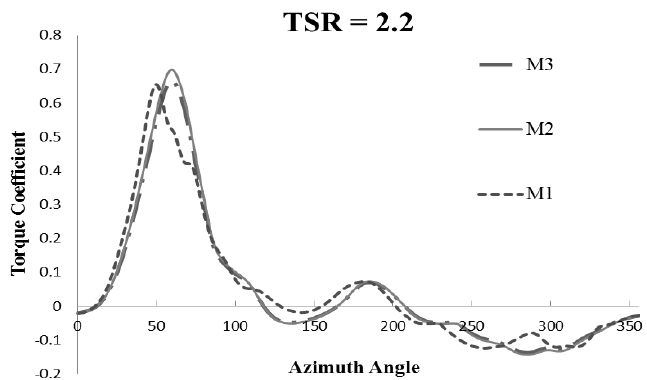
Figure 6. Variation of torque coefficient by azimuth angle for different mesh densities at tip speed ratio (TSR) = 2.2.